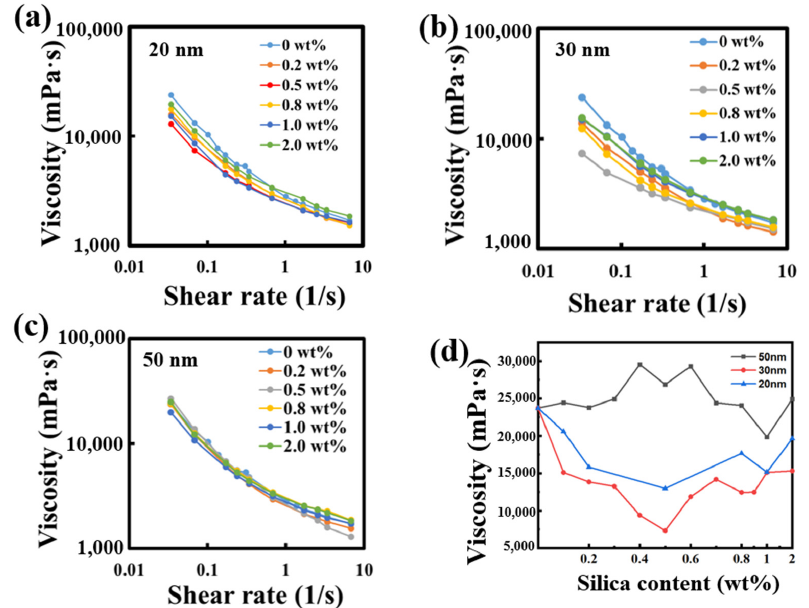
Figure 2. Relationship between the rheological properties of PVDF/SiO 2 and the content of nanopar- ticles with di ff erent diameters. ( a ) PVDF/20 nm SiO 2 ; ( b ) PVDF/30 nm SiO 2 ; ( c ) PVDF/50 nm SiO 2 . ( d ) Viscosity variation with di ff erent contents and diameters of nano-SiO 2 at the shear rate of 0.034 s − 1 .